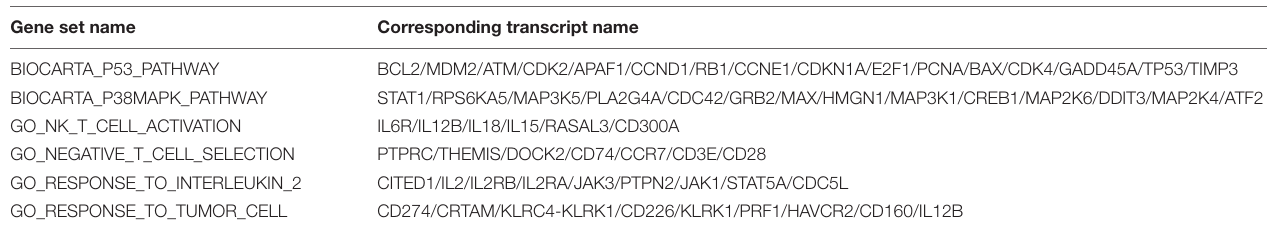
TABLE 4-1 | The corresponding transcript names for each pathway in this